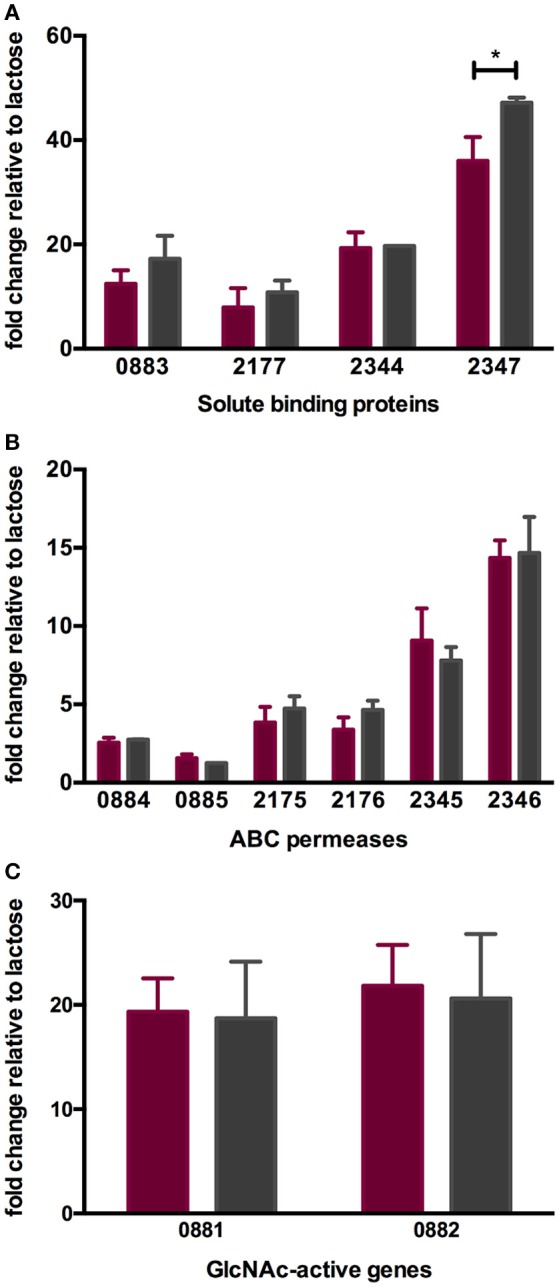
ATCC 15697 gene expression while subsisting on milk oligosaccharides as a sole carbon source. The x-axis represents gene locus tags of Family 1 solute binding proteins (A), ABC permeases (B), and GlcNAc-active genes (C). The y-axis depicts the fold changes in gene expression relative to the control lactose as measured by qRT-PCR. LNT and LNnT are denoted in purple and gray. The error bars show standard deviations of three biological replicates except for LNnT. *p < 0.05 evaluated by one-way ANOVA and Tukey's multiple comparison.